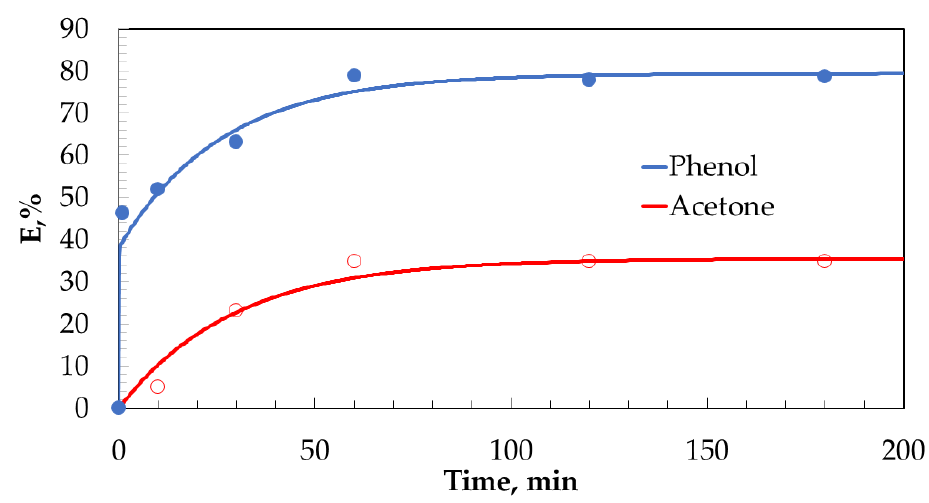
Figure 11. Sorption of acetone and phenol at different contact times at a temperature of 25 ± 2 °C; L/S = 50.